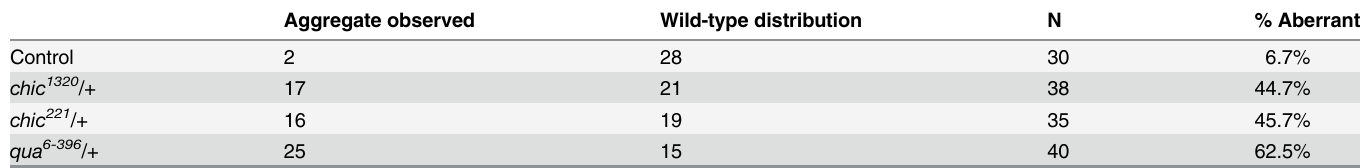
Table 1. Wolbachia aggregates within the germarium of Drosophila melanogaster